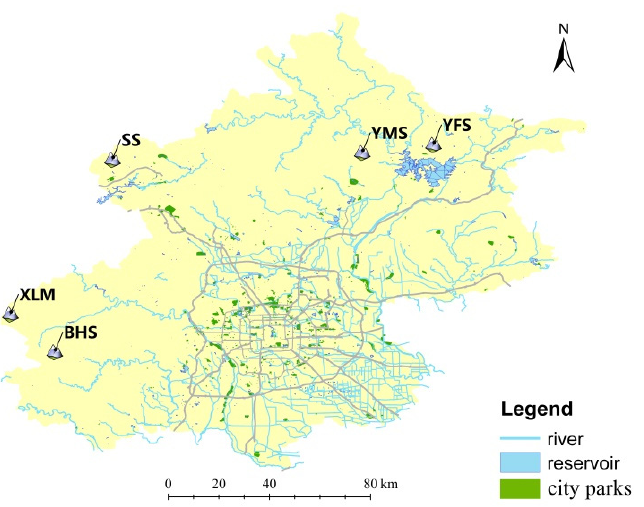
Figure 1. Fecal sampling areas for analyses of the genetic structure of leopard cats in Beijing. BHS represents the Baihuashan reserve, XLM represents the Xiaolongmen reserve, SS represents the Songshan reserve, YMS represents the Yunmengshan reserve, and YFS repre- sents the Yunfengshan reserve. They are the same designations in the following